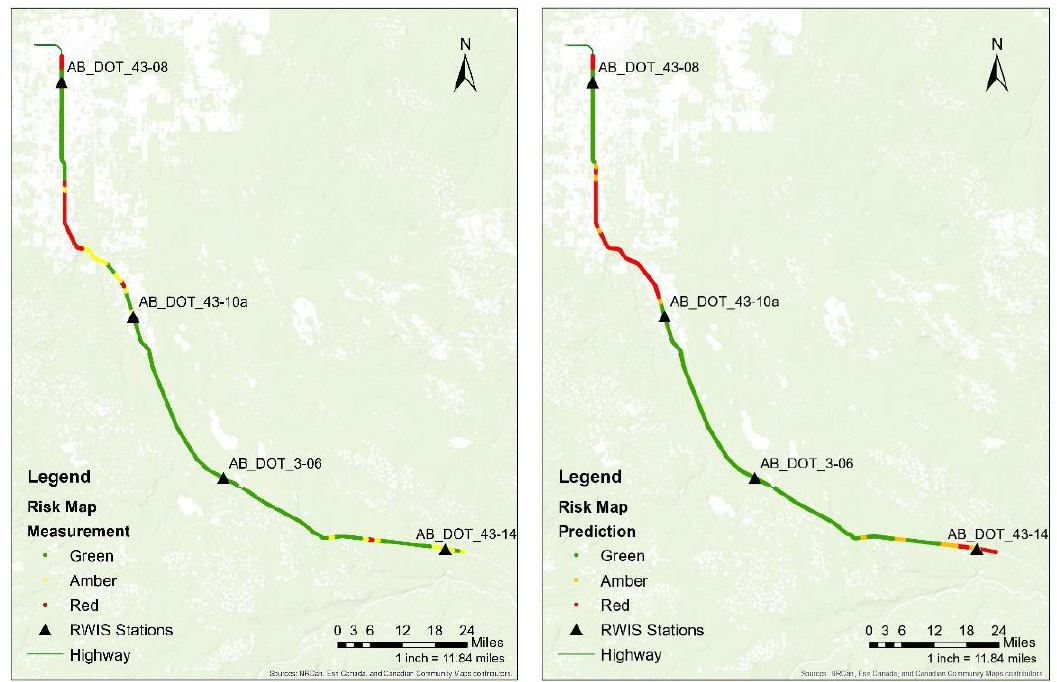
Figure 10. Road risk warning map with measured ( left ) and predicted friction ( right ).